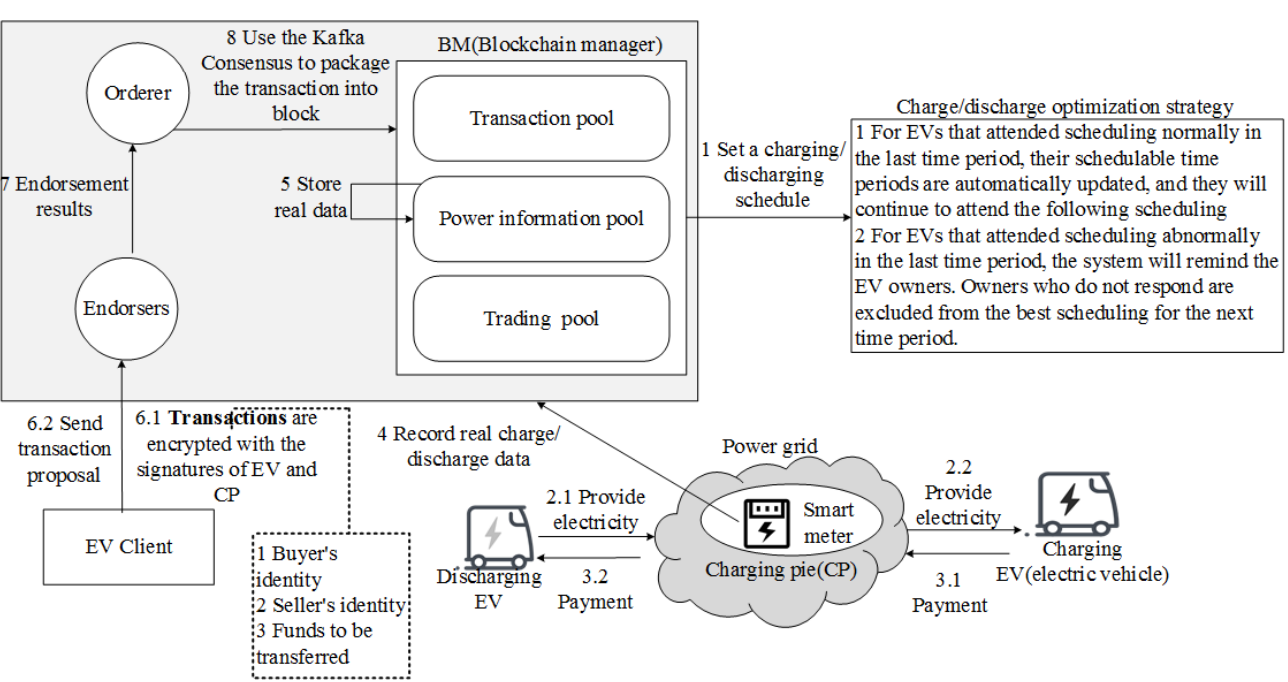
Figure 28. Reconstruction diagram of reference [57].